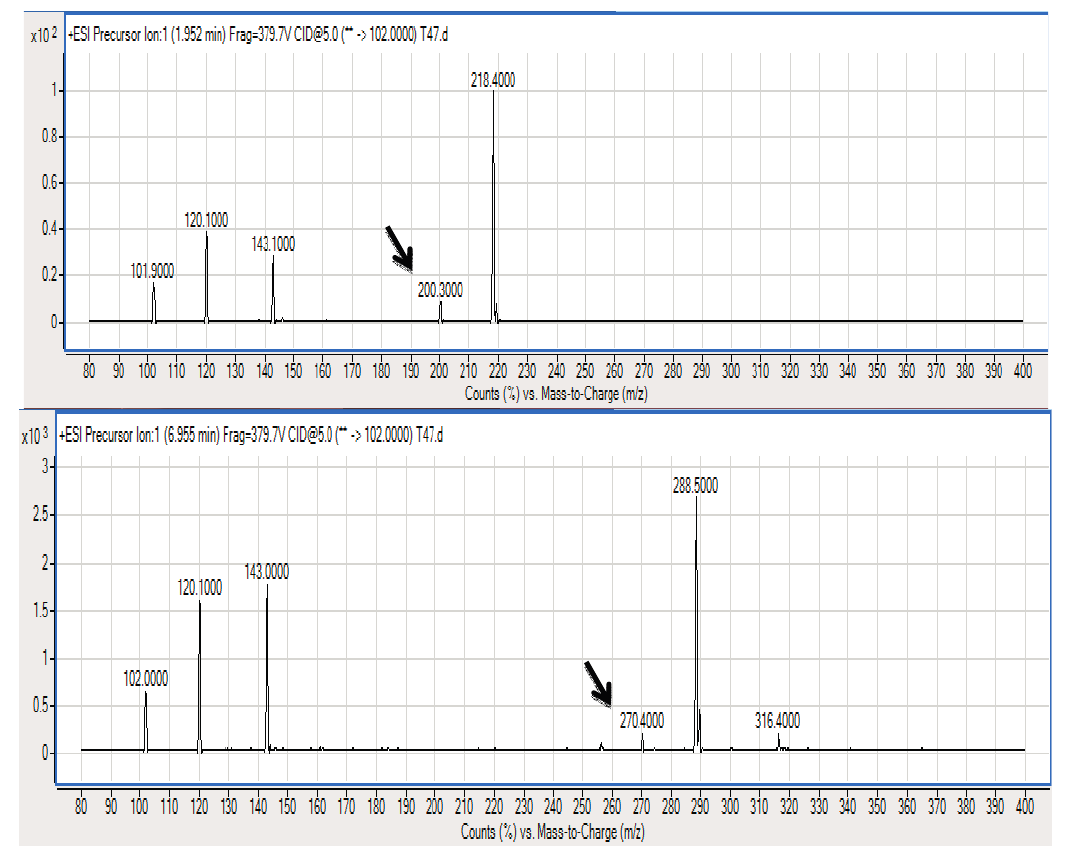
Figure 3. Mass spectrometry analysis of spent supernatants extract of V. brasiliensis strain T33. Upper Panel: mass spectrum of C6-HSL ( m/z 200.3000; retention time 1.952 min) (marked by arrow); Lower Panel: mass spectrum of 3-oxo-C10 HSL ( m/z 270.4000; retention time 6.955 min) (marked by